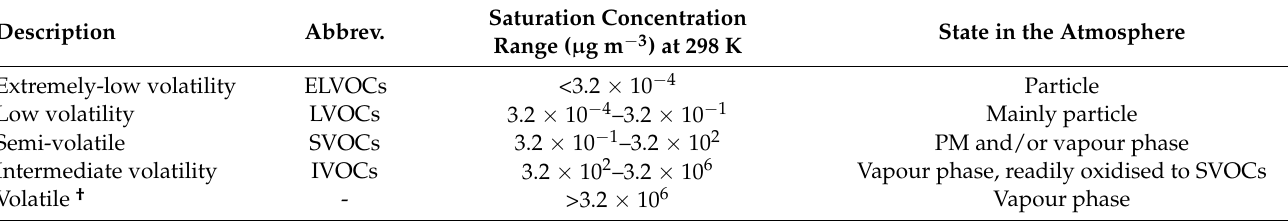
Table 4. Volatility classes of VOCs